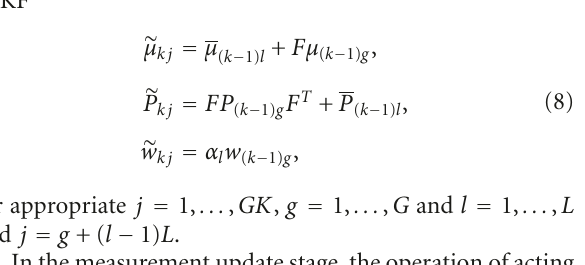
Algorithm: CPF with BS. (1) Conduct the experiment